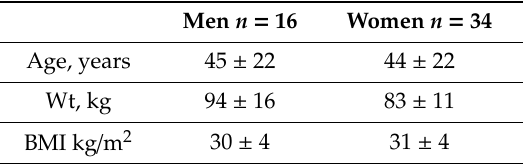
Table 1. BMI—Body Mass Index.